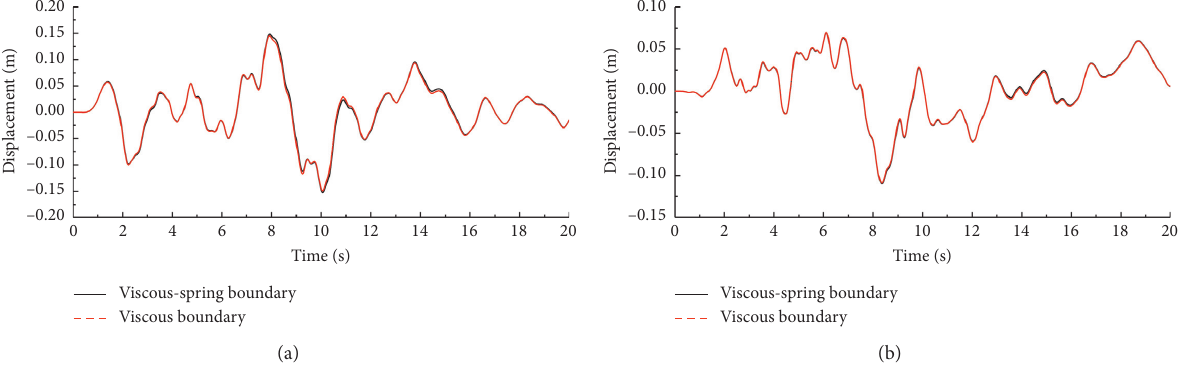
Figure 17: Time histories of horizontal and vertical displacements at dam heel. (a) Horizontal displacements. (b) Vertical displacements.